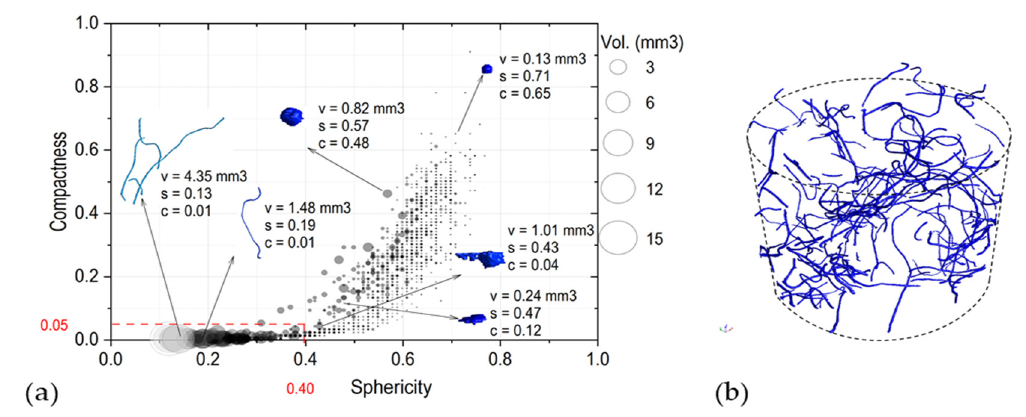
Figure 5. ( a ) Histogram of grayscale distribution of the images of the 1.5% specimen before and after surface determination showing the materials peaks and the threshold selected. ( b ) View of the inclusions after segmentation (no filter), 1.5% fiber content.